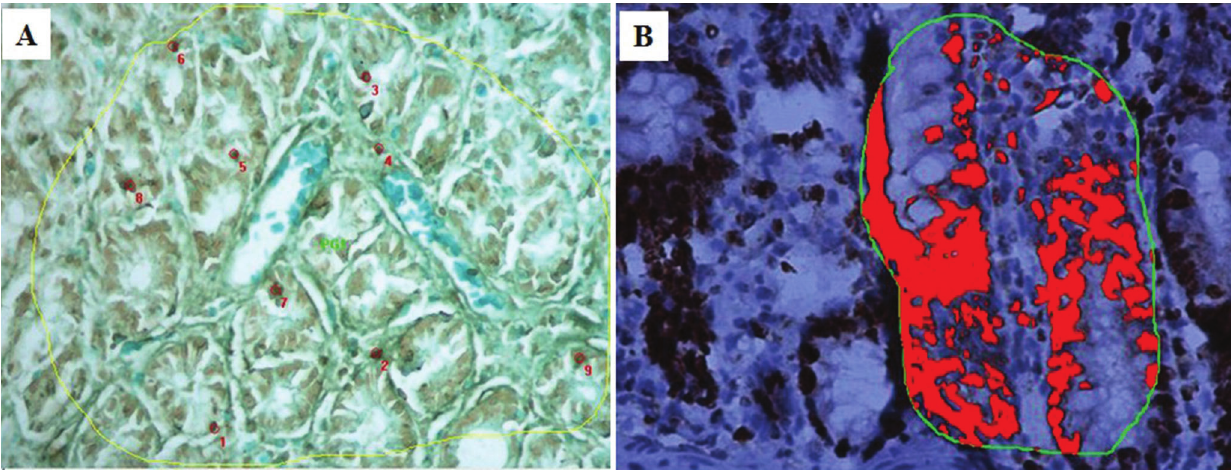
Figure 5 - Immunohistochemical analyses of TUNEL (A) and Ki-67 (B) staining at 60 min after reperfusion. Note the increased numbers of positively stained cells at this time point compared to the control.